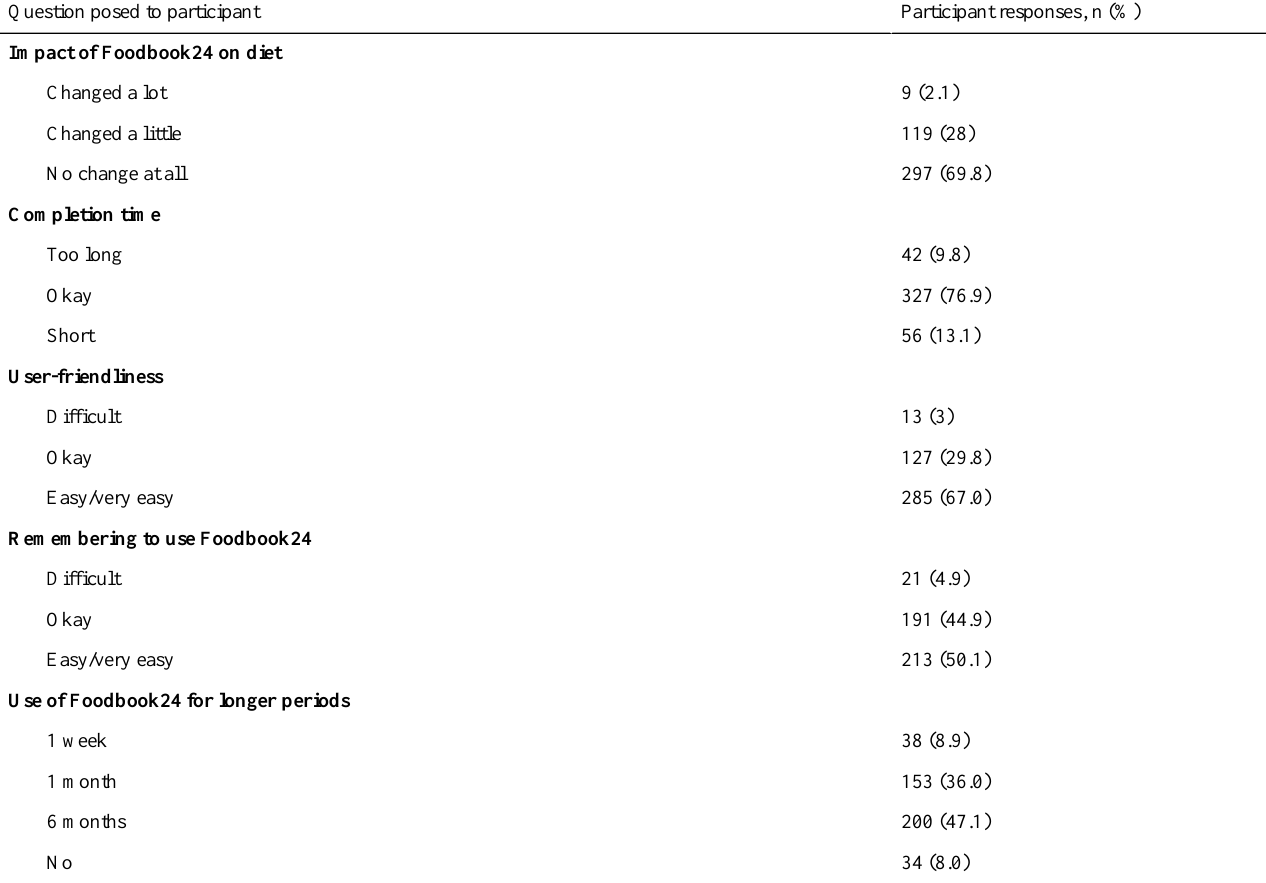
Participant responses, n (%)Question posed to participant